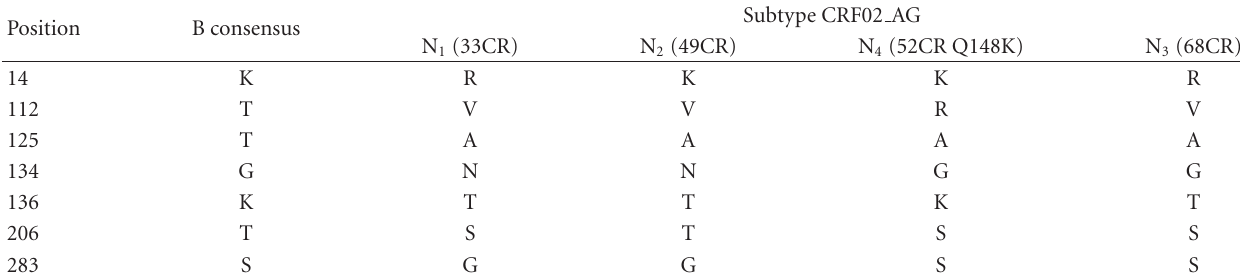
Table 1: Amino acid variations at the positions putatively a ff ecting the susceptibility to INSTI in 4 isolated HIV-1 subtype CRF02 AG IN coding